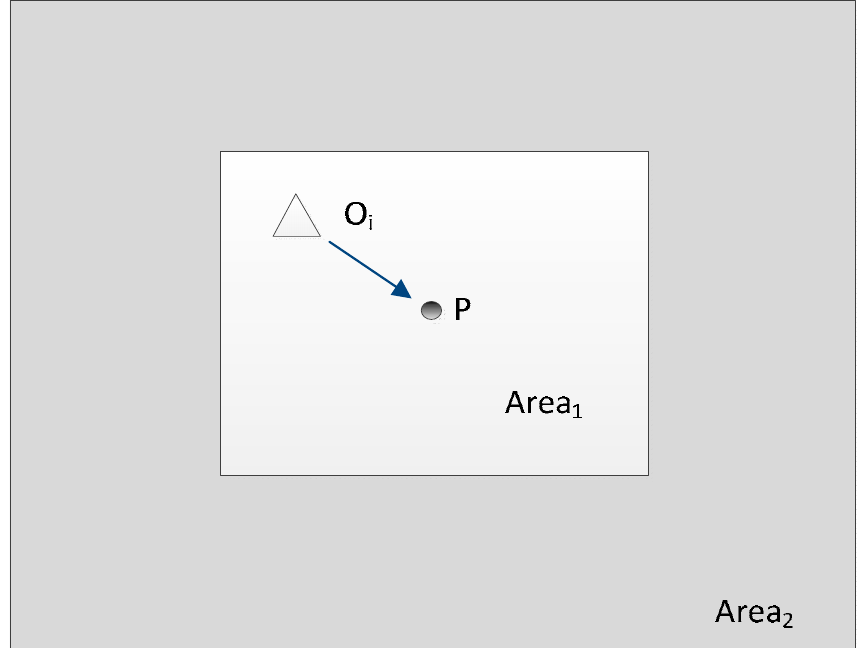
Figure 5. Object position adjustment.